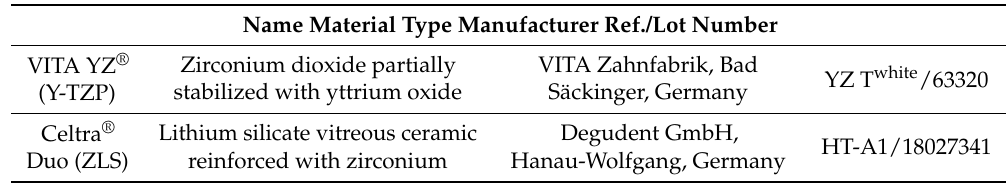
Table 2. Summary of the characteristics of the studied